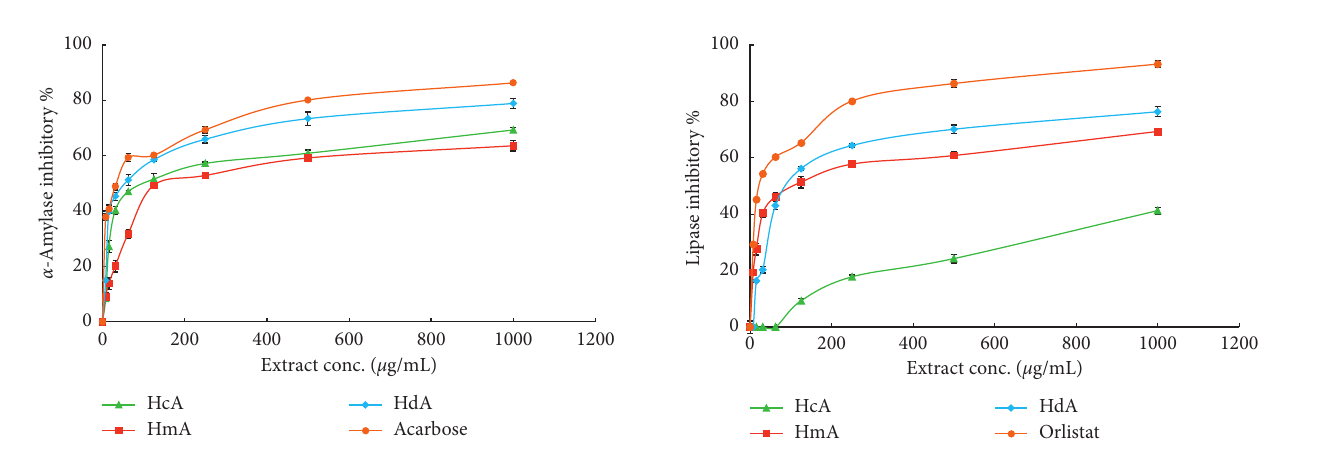
Figure 7: In vitro lipase inhibitory activity of aqueous extracts of tested Hibiscus deflersii (HdA), H. micranthus (HmA), and H. calyphyllus (HcA) in comparison with orlistat standard. Table 3: IC 50 of tested aqueous extracts of Hibiscus deflersii (HdA), H. micranthus (HmA), and H. calyphyllus (HcA) against pancreatic lipase enzyme.